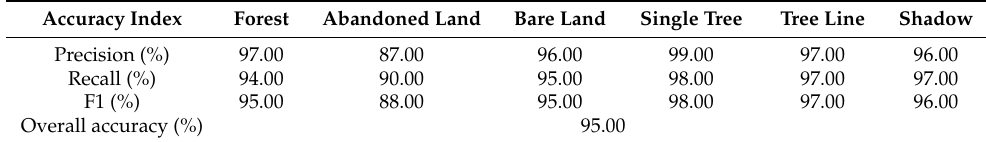
Table 1. Accuracy of classification of subtle landscape elements.